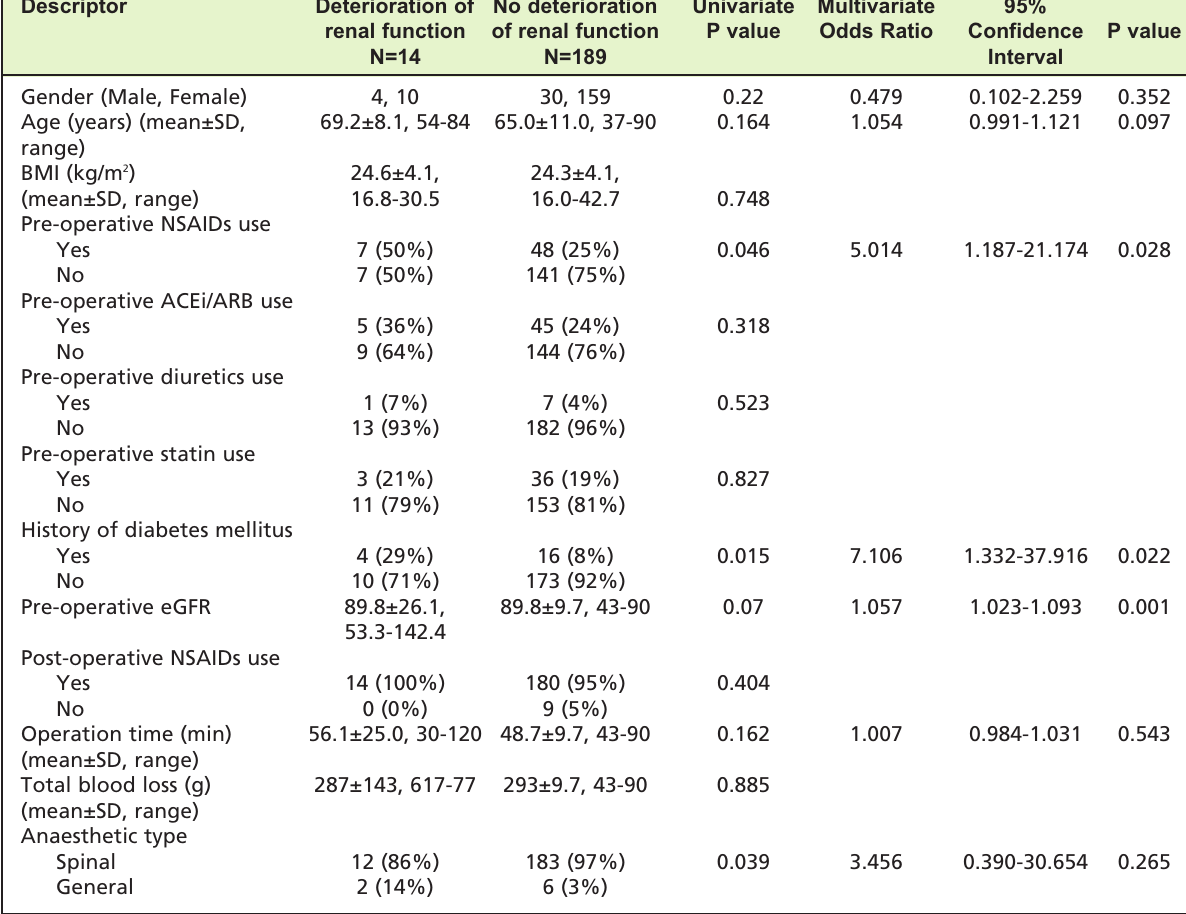
Factors associated with deterioration of renal function one week after Table III: